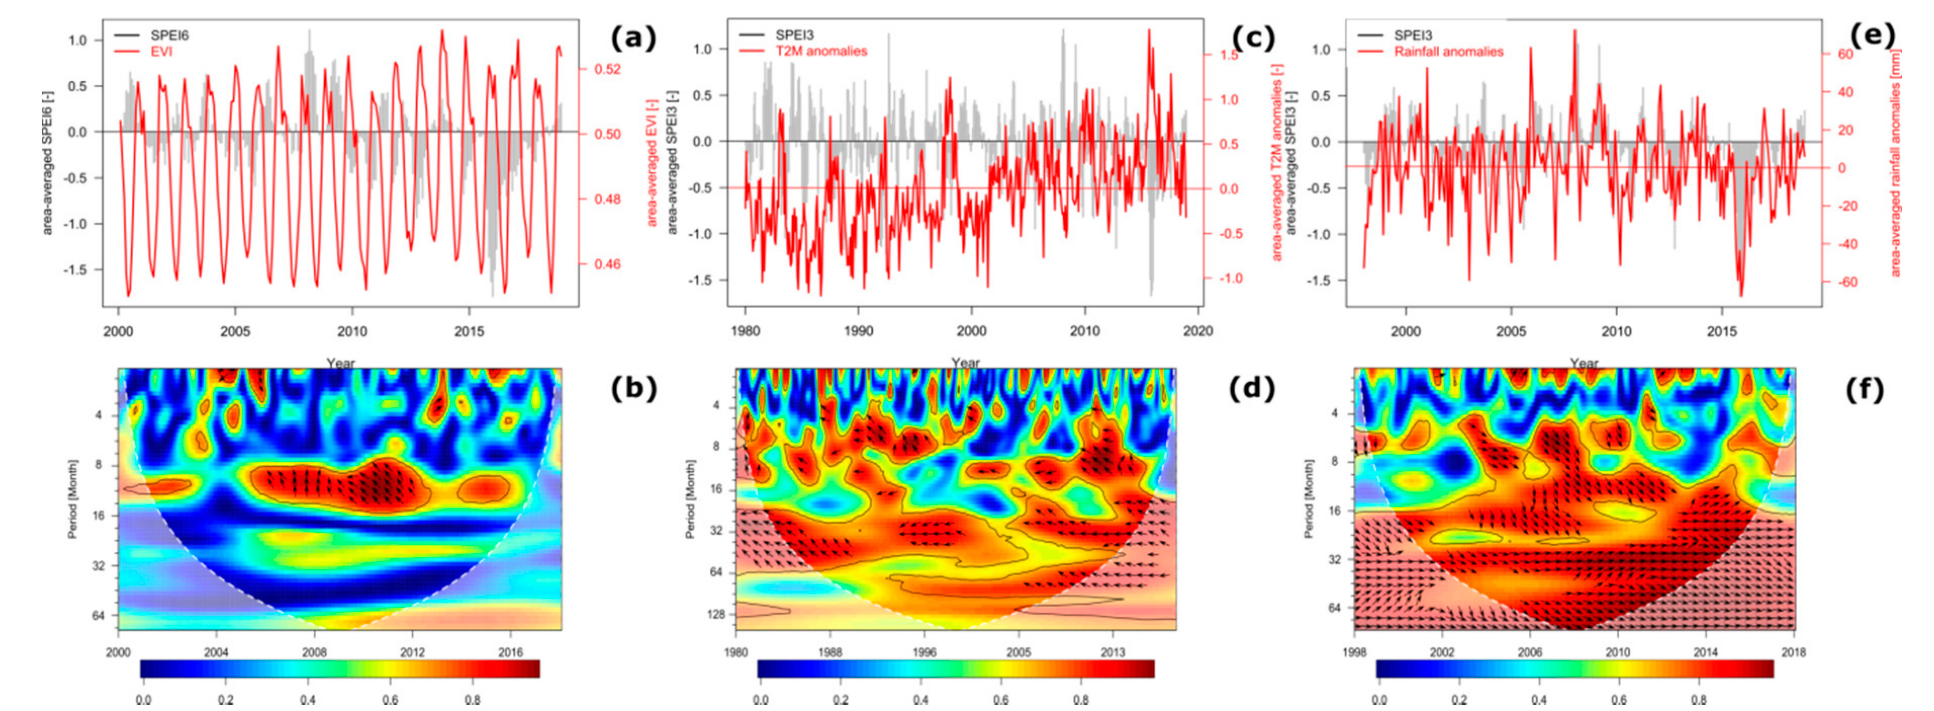
Figure 7. Temporal variation of the area-averaged values over the entire ARB of the: ( a ) SPEI6 against EVI during 2001–2018; ( c ) SPEI3 against T2Ma during 1980–2018; ( e ) SPEI3 against RA during 1998–2018 in the ARB; and the squared wavelet coherence between the times series shown in: ( b ) Figure 7a; ( d ) Figure 7c; and ( f ) Figure 7e. Thick contours enclose the areas with correlations statistically significant at 95% confidence level against red noise. Semitransparent areas indicate the ‘cone of influence’ where the edge effects become important; therefore, they were not analyzed [73]. The relative phase relationship is shown as arrows (with in-phase pointing right, anti-phase pointing left, SPEI6 or SPEI3 leading auxiliary variable by 90 ◦ pointing straight down, and auxiliary variable leading SPEI6 or SPEI3 by 90 pointing straight